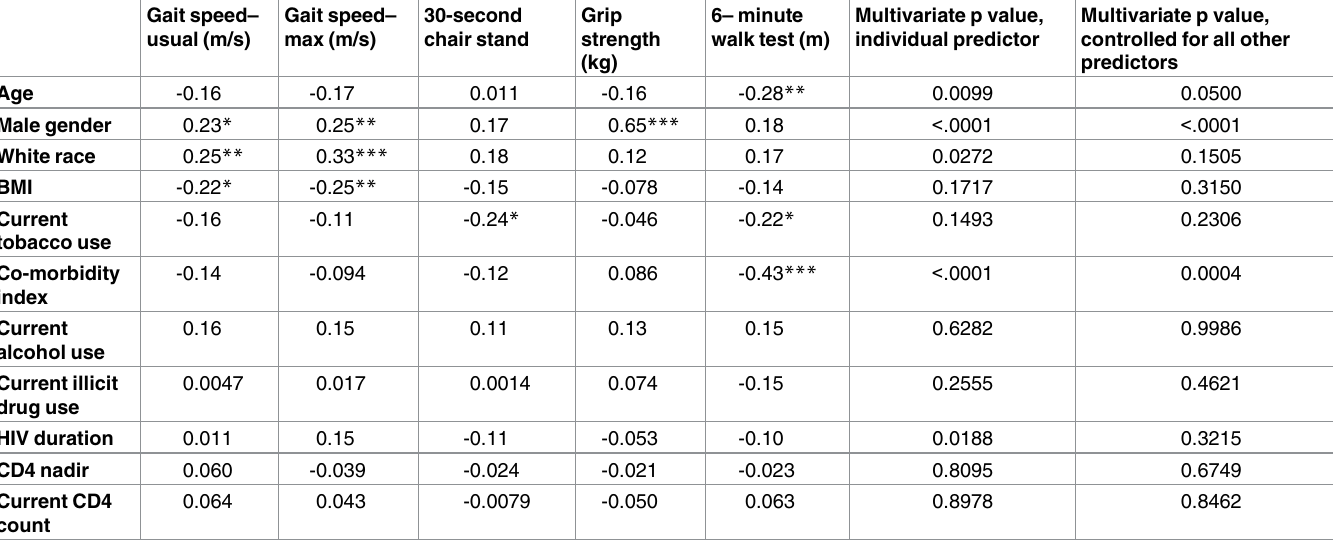
Table 2. Correlation between clinical characteristics and physical